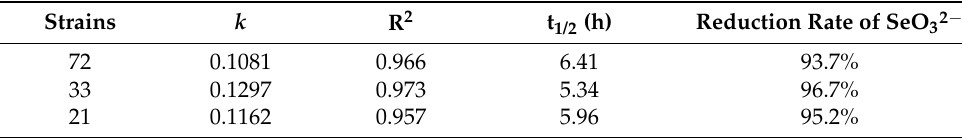
Table 1. Reduction property of SeO 32 − by the strain 72, 21, and 33.